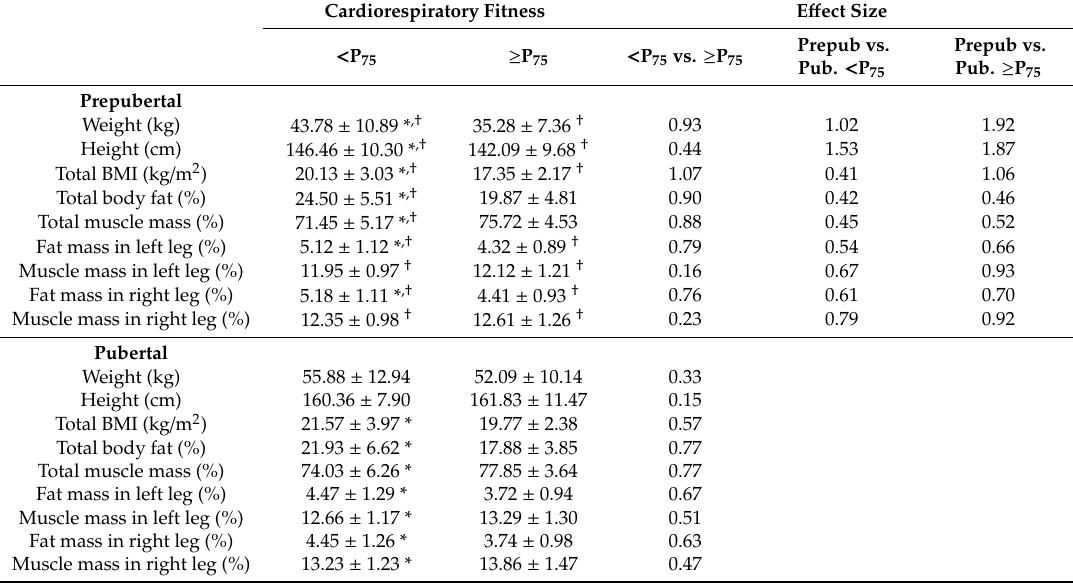
Table 2. Comparisons of body composition between pubertal status and cardiorespiratory fitness.